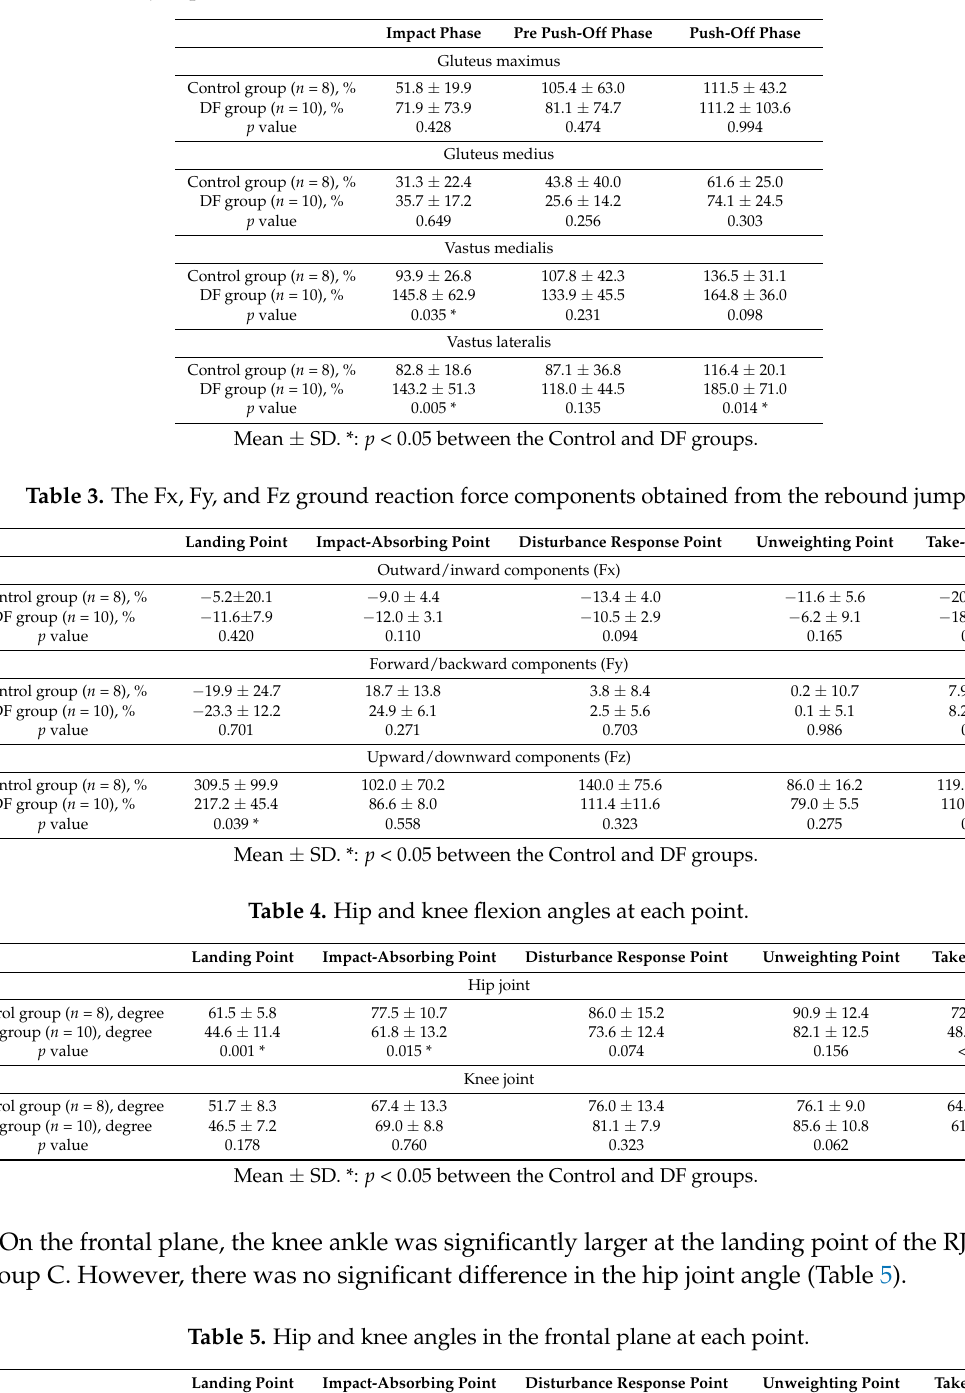
Table 2. The electromyographical EMG activity (%MVC) of lower extremity muscles in various phases of the rebound jump.